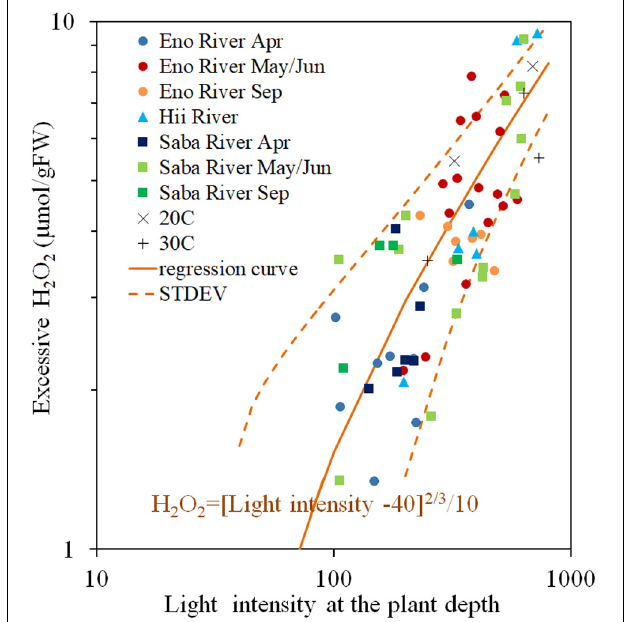
FIGURE 5 | Photosynthesis-produced H 2 O 2 concentration (Excessive H 2 O 2 ) of E . densa tissue as a function of light intensity. The sample collected month is represented by the year and the month indicated in the legend. Eno, Saba, and Hii represent Eno, Saba, and Hii Rivers, including their tributaries, respectively. When the light intensity is lower than 40 µ mol/m 2 /s, the excessive H 2 O 2 concentration was 0 µ mol/gFW. The regression curve in the excessive H 2 O 2 concentration and the excessive light intensity from 40 µ mol/m 2 /s condition is postulated by a rigid line, and the standard deviation is shown by the dashed line. “Light” is the light intensity at the sample depth ( µ mol/m 2 /s), and the excessive H 2 O 2 concentration, H 2 O 2 rad ( Temp ), is expressed in µ mol/gFW. The “ H 2 O 2 rad ” denotes the light induced H 2 O 2 content. The Exp 20 o C and Exp 30 o C represent the excessive H 2 O 2 concentration quantified in experiments under 20 and 30 ◦ C controlled